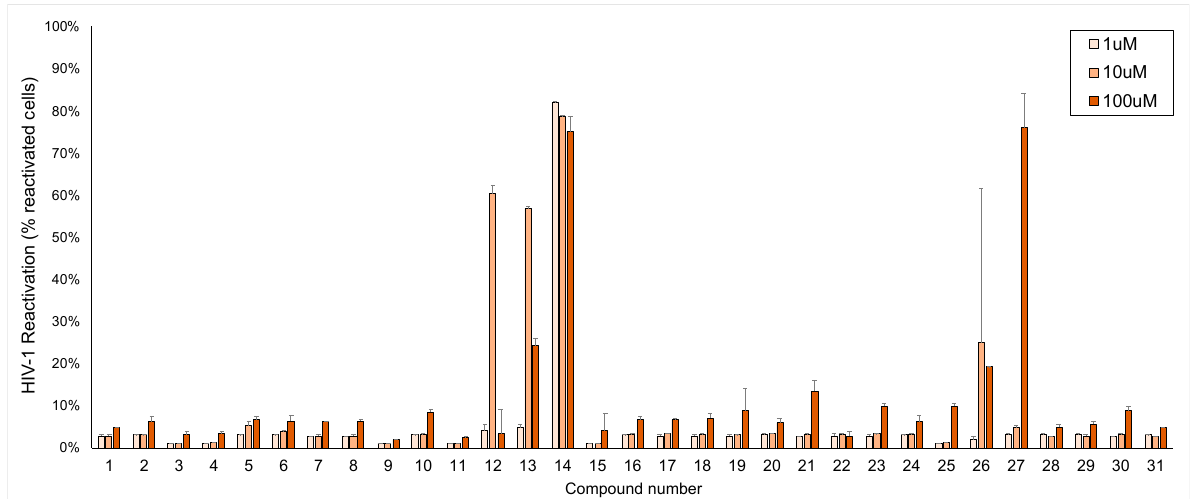
Figure 4. HIV-1 latency reversal activity of compounds 1 – 31 on J-Lat 10.6 cells in vitro .